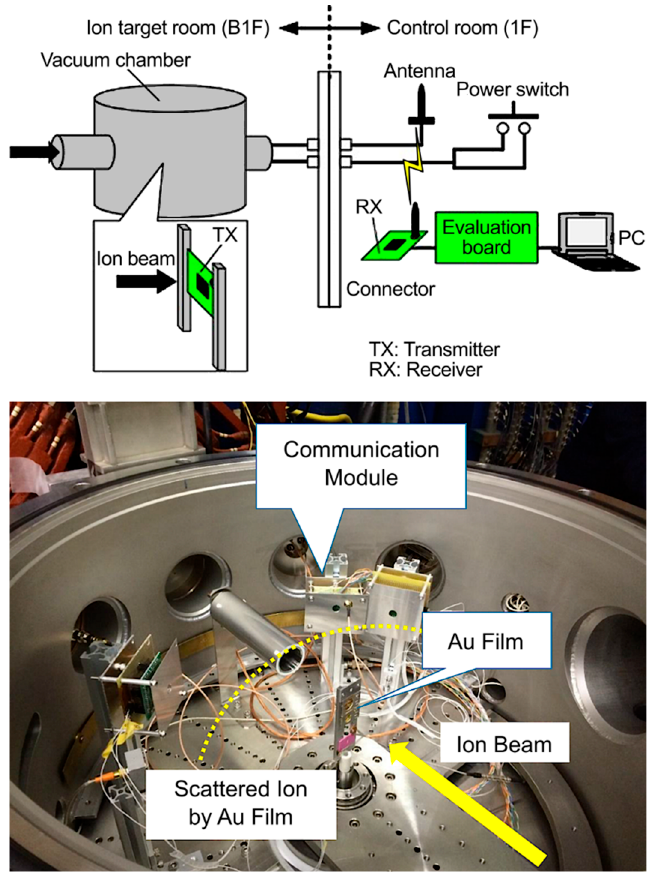
Figure 7. Schematic of the test equipment and its arrangement in the chamber.